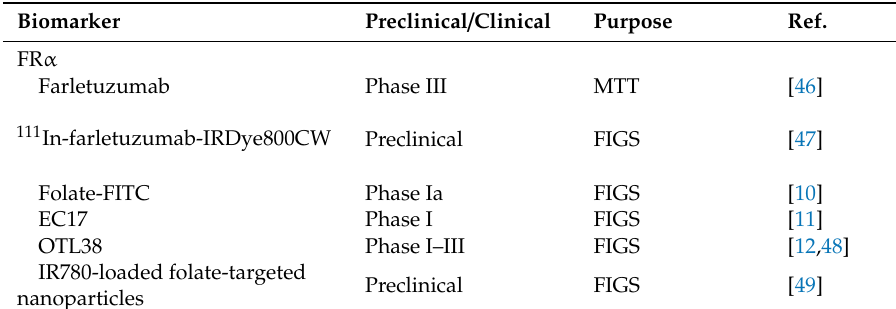
patients based on the results of the GOG213 and OCEANS